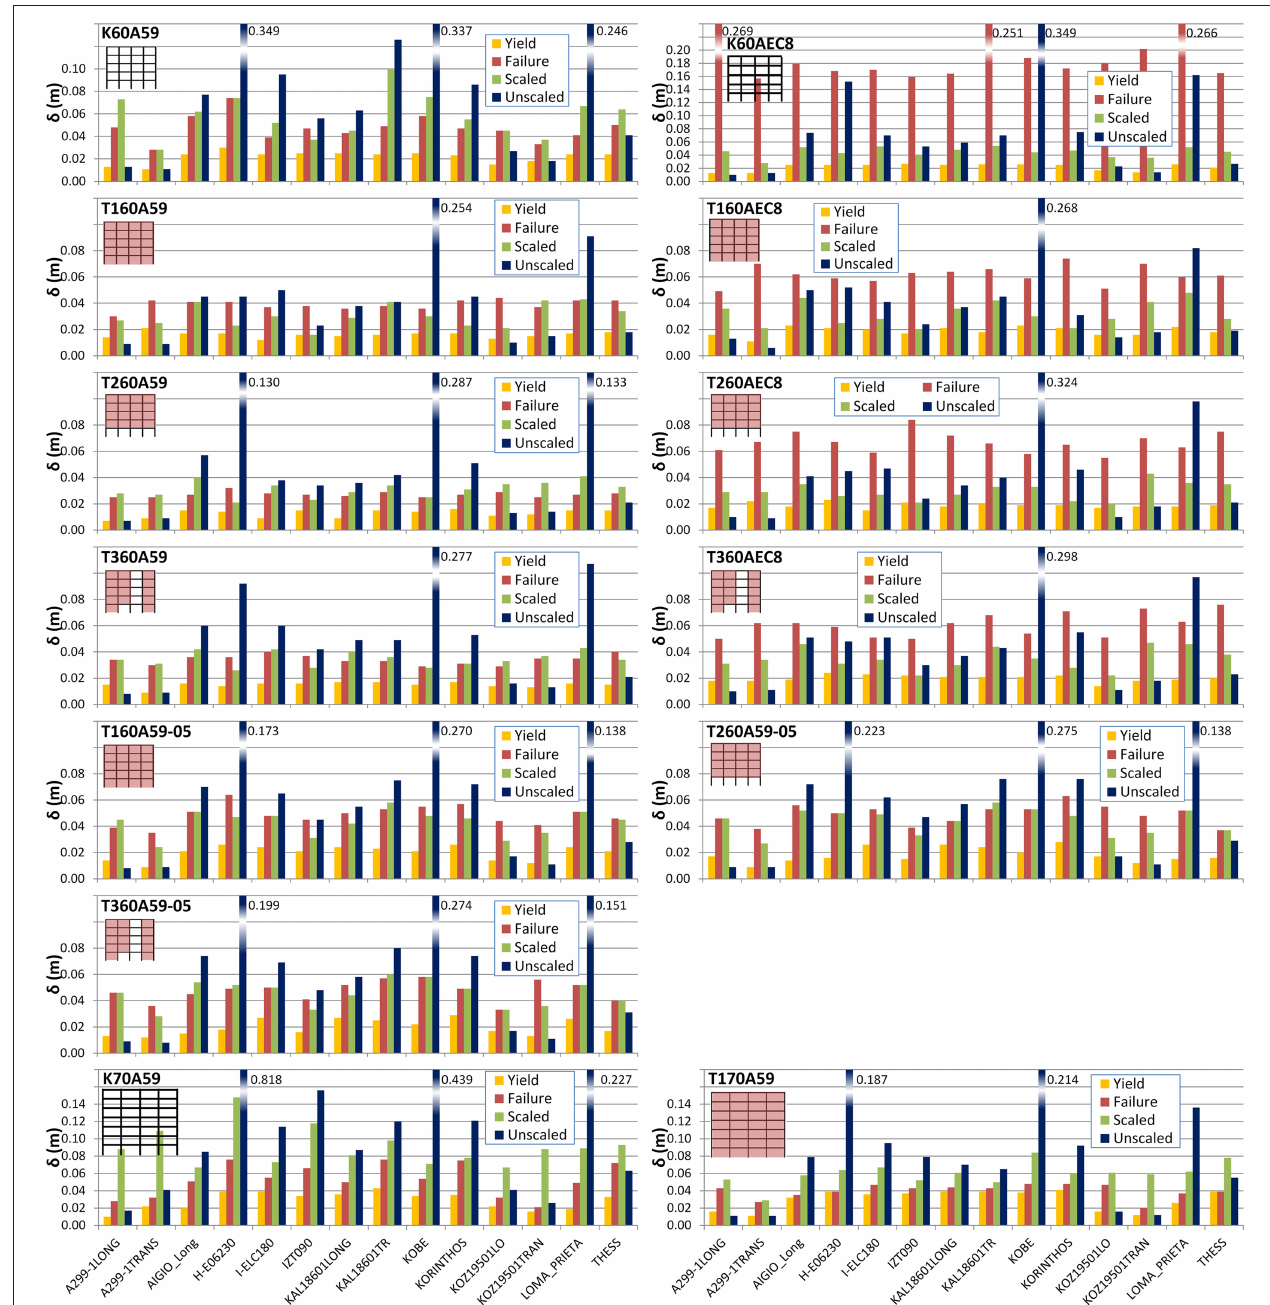
FIGURE 10 | Roof displacements from IDA analysis for the 14 records. Values for yield, failure, the scaled record to the design spectrum and the unscaled (raw) record are shown.